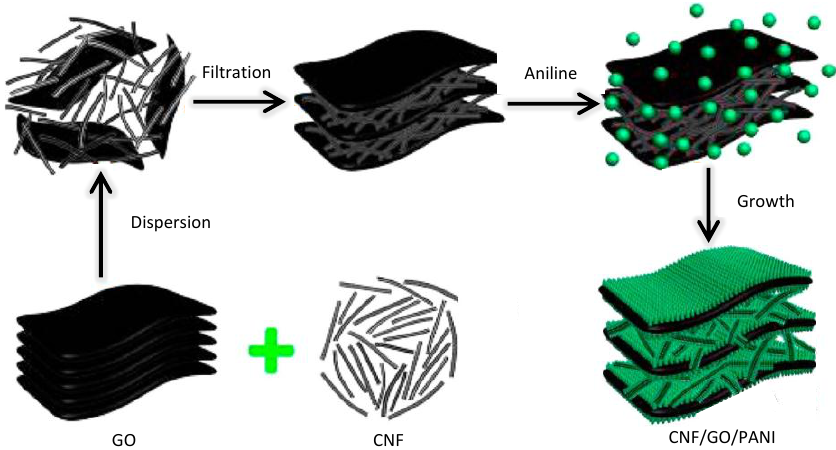
Figure 15. Formation mechanism of the CNF/GO/PANI film. With permission from [103]; Copyright 2013, American Chemical